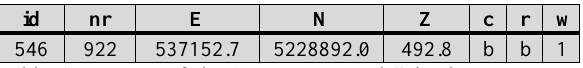
Table 1. Excerpt of the “accuracy sample” in the assessment with independent 3D checkpoints (id=index, nr=number, E=Easting, N=Northing, Z=elevation, c=classification, r=reference, w=weight).